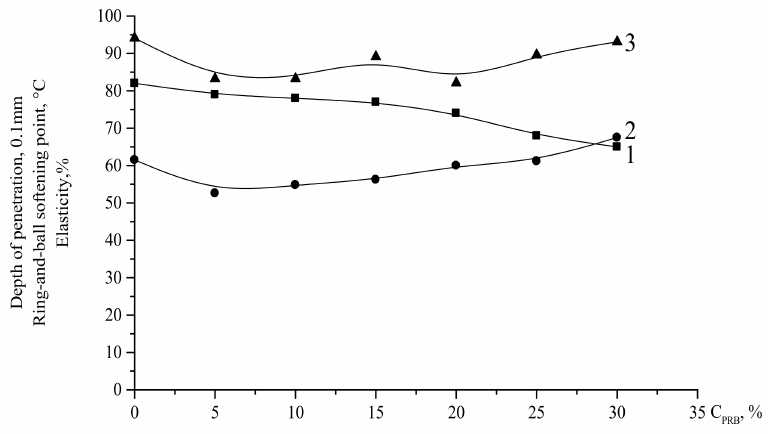
Figure 3. Dependence of depth of penetration (1), ring and ball softening point (2), elasticity (3) on petroleum road bitumen concentration.